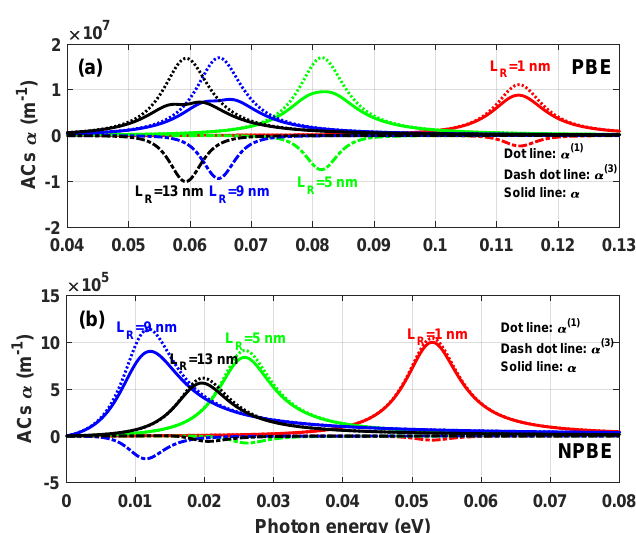
Figure 3. The linear α ( 1 ) ( ω ) , the third-order nonlinear α ( 3 ) ( ω ) and the total OACs α ( ω ) versus the photon energy ¯ h ω with L L = 8 nm, L B = 1 nm, for two case: Without ( a ) and with ( b ) considering the influence of